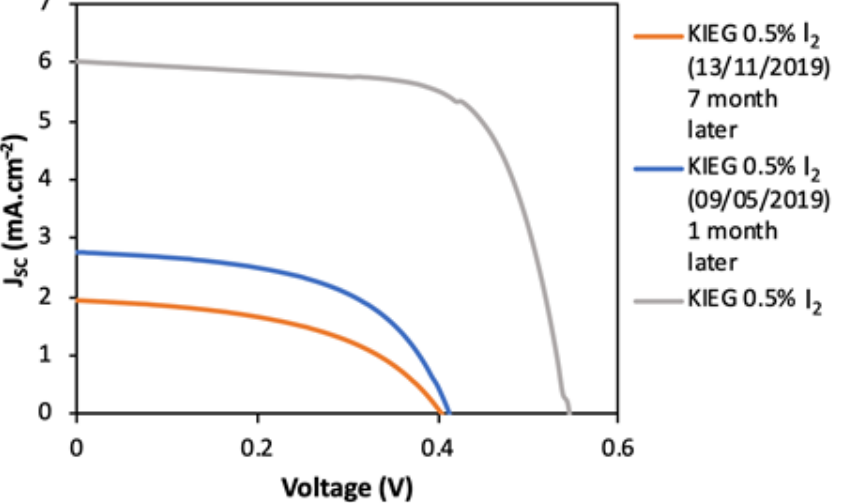
Figure 3. J–V curves of DSSCs based on dye N719 for the alkali DES KI:EG as electrolyte, under 100 mW.cm −2 simulated AM 1.5 illumination: describing the decrease of the performance of the cell over time.